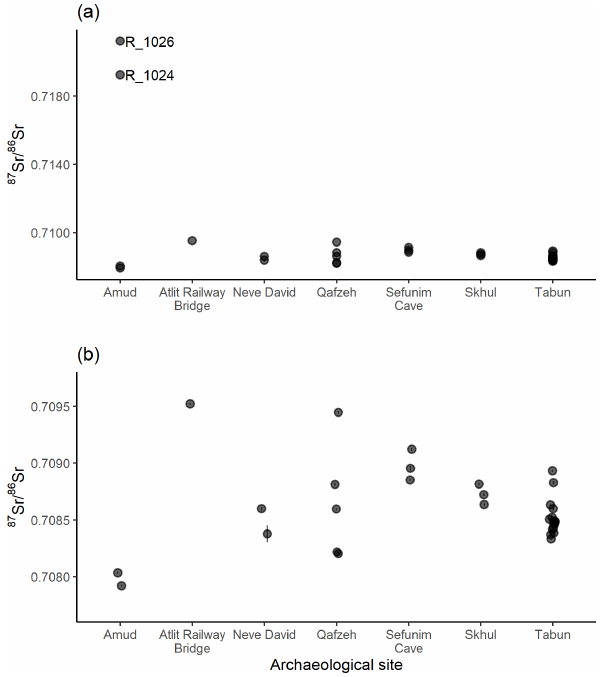
Figure 7. 87 Sr / 86 Sr of soils collected from archaeological sites in Israel. (a) All data, (b) subset excluding the highest 87 Sr / 86 Sr ratios of samples R_1024 and R_1026 from Amud to display the range of variability in the rest of the data